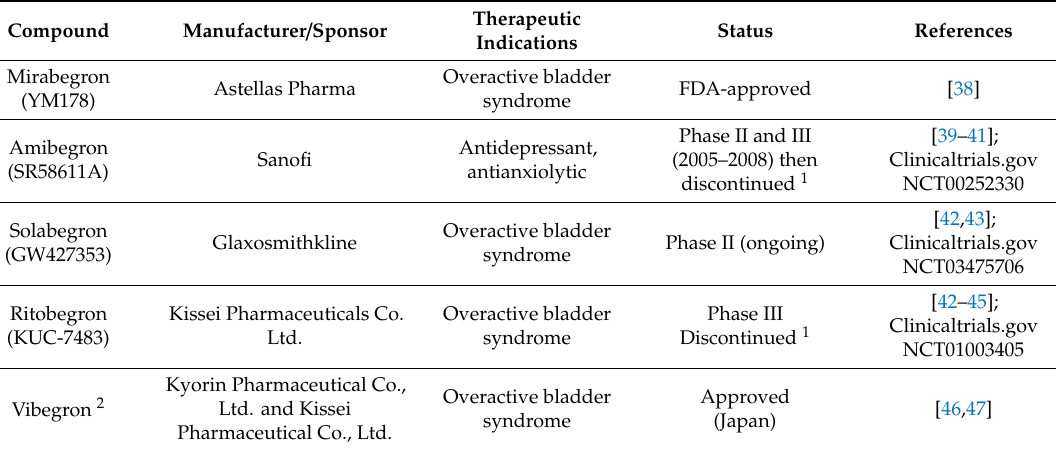
Table 1. β 3 -AR agonists tested in clinical